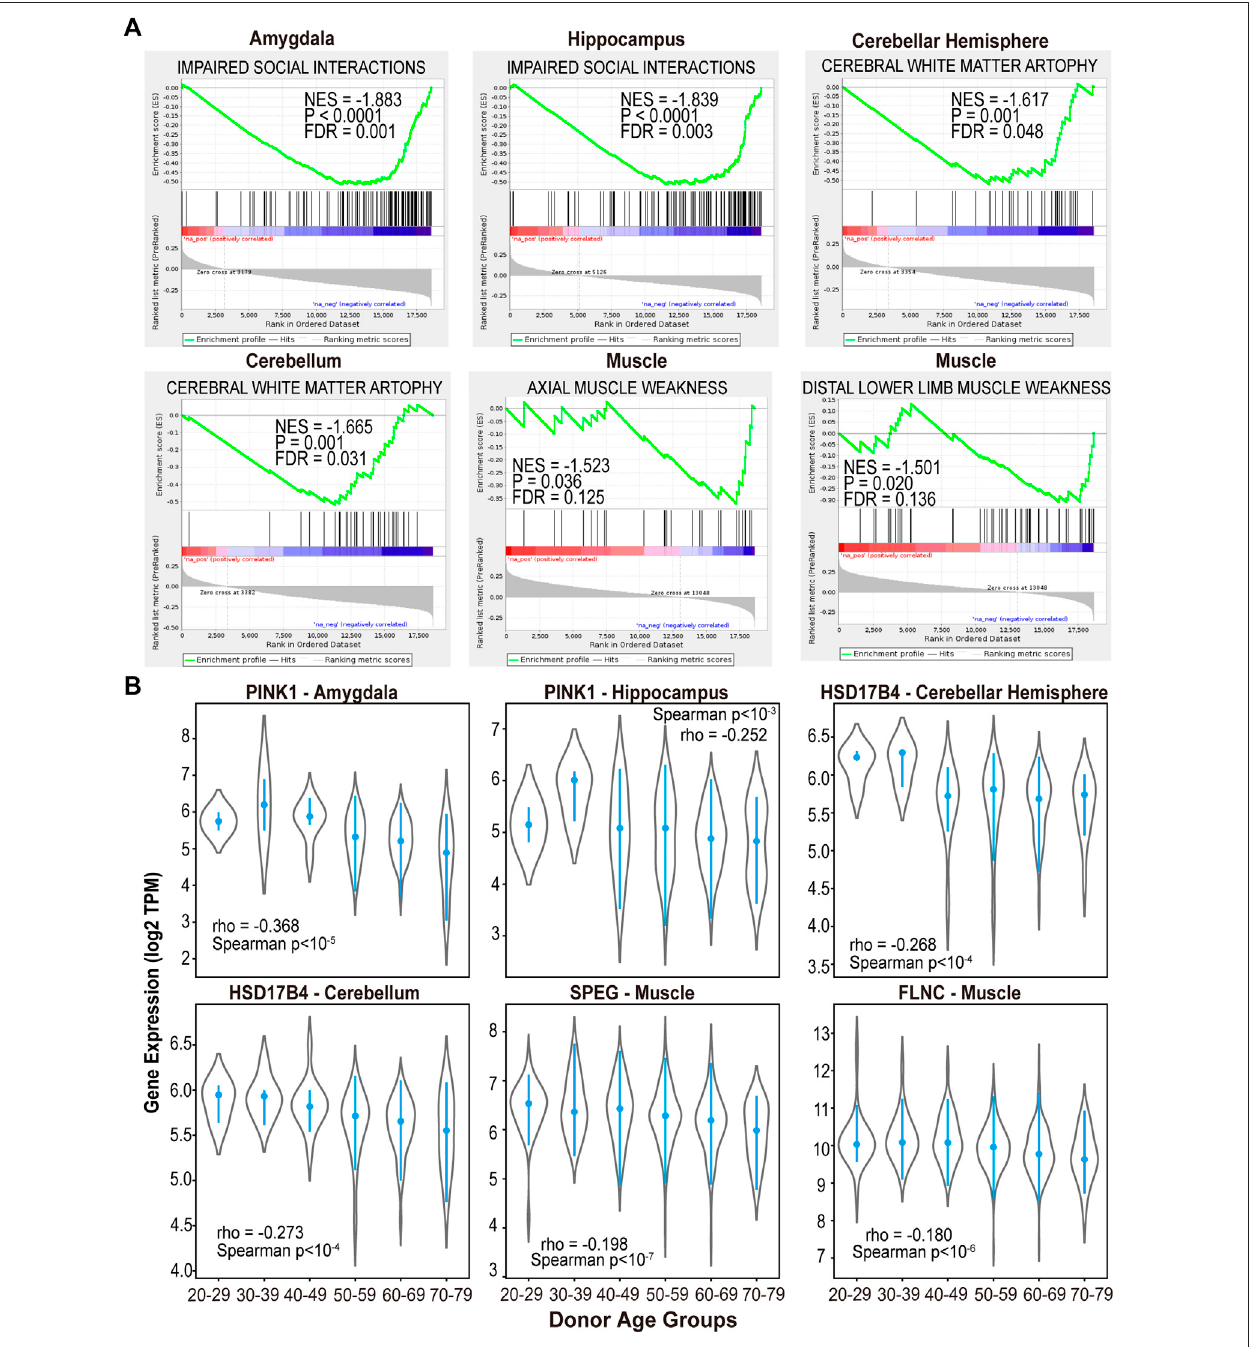
FIGURE 3 | The aging-associated genes in normal brain and muscle tissues are highly overlapped with brain and muscle aging phenotypes. (A) GSEA analysis of aging-associated genes using gene sets derived from the Human Phenotype Ontology. (B) Decreased gene expression in normal brain and muscle tissues of aged